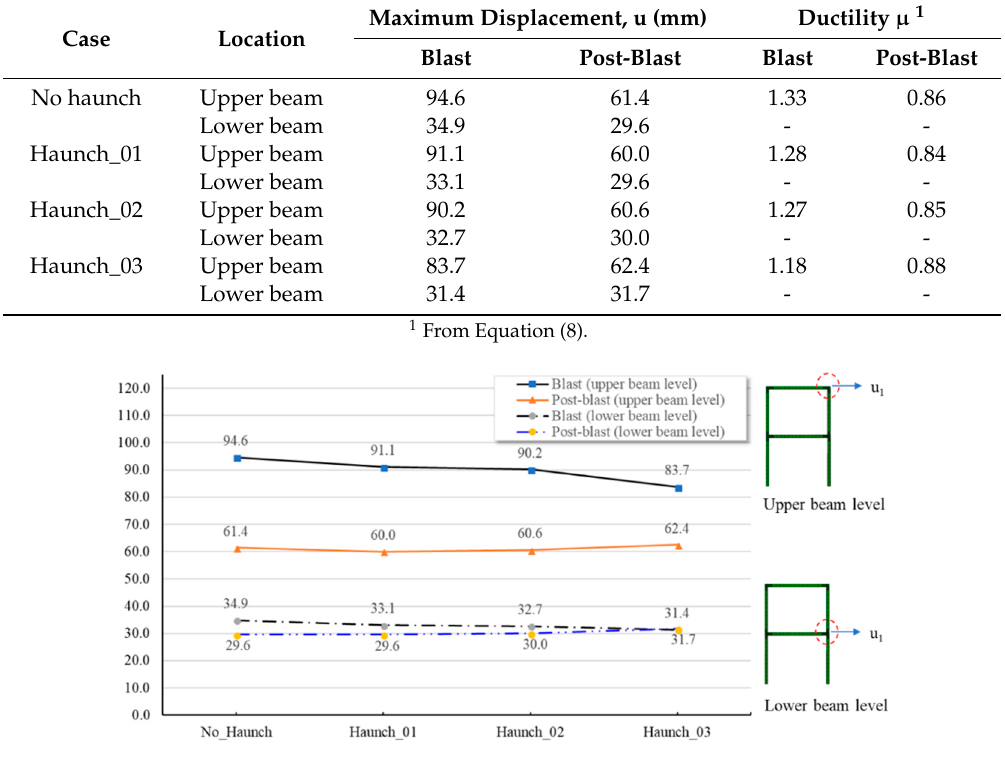
Table 1. Summary of maximum displacement at all beam elevations for connection types of all cases considered in this study.